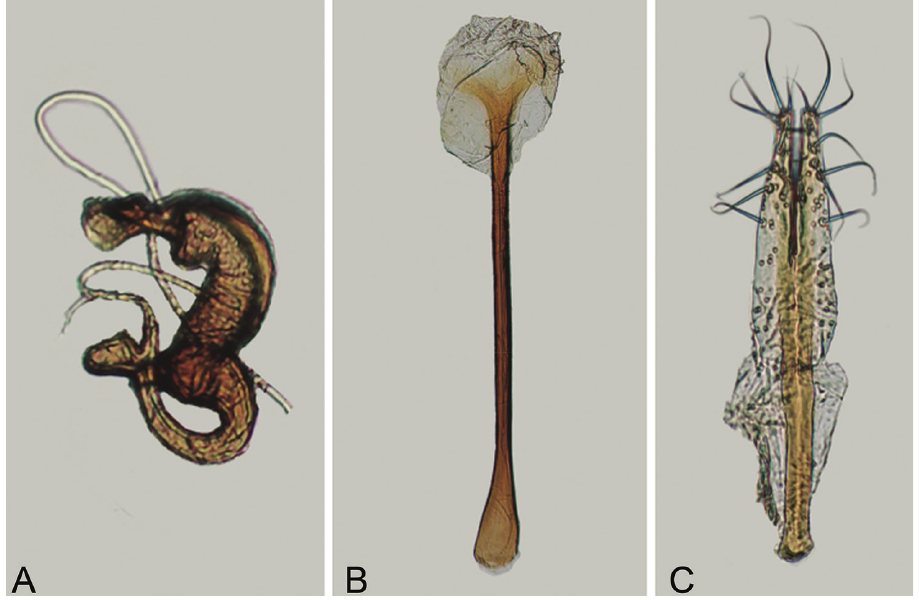
Figure 20. Andersonoplatus merga . A Spermatheca B Tignum C Vaginal palpi. Andersonoplatus merida sp.